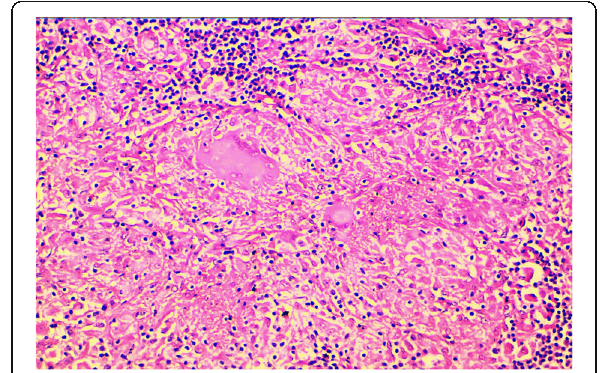
Fig. 2 A higher magnification showing areas of caseous necrosis, epithelioid cells, and giant multinucleated cells, surrounded by lymphocytes (hematoxylin eosin stain ×